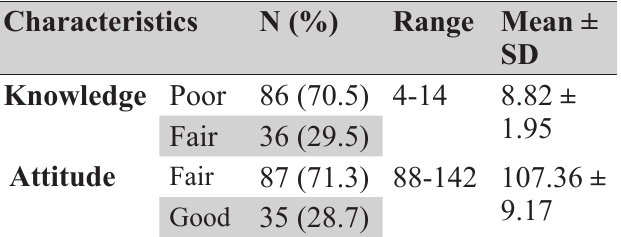
Table 3. Level of knowledge and attitude of participants